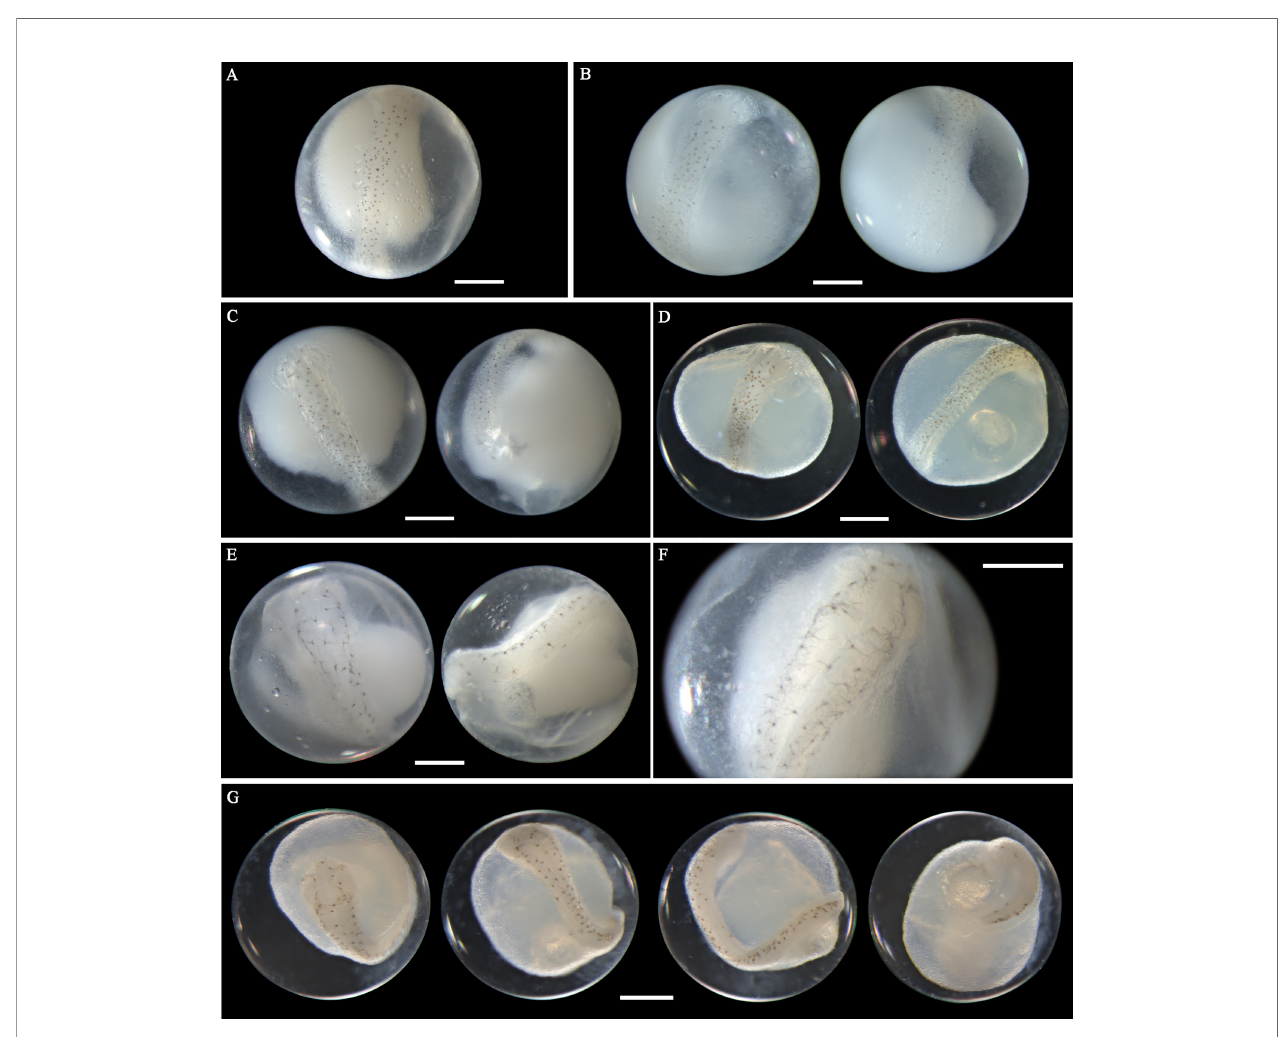
FIGURE 7 | Images of Acanthopagrus paci fi cus eggs (A – C) fi xed in ethanol at middle stage, (D) fi xed in formalin at middle stage, (E, F) fi xed in ethanol at late stage, and (G) fi xed in formalin at late stage. Images within each panel represent the same egg photographed from different observation views. Scale bar for images =200 m